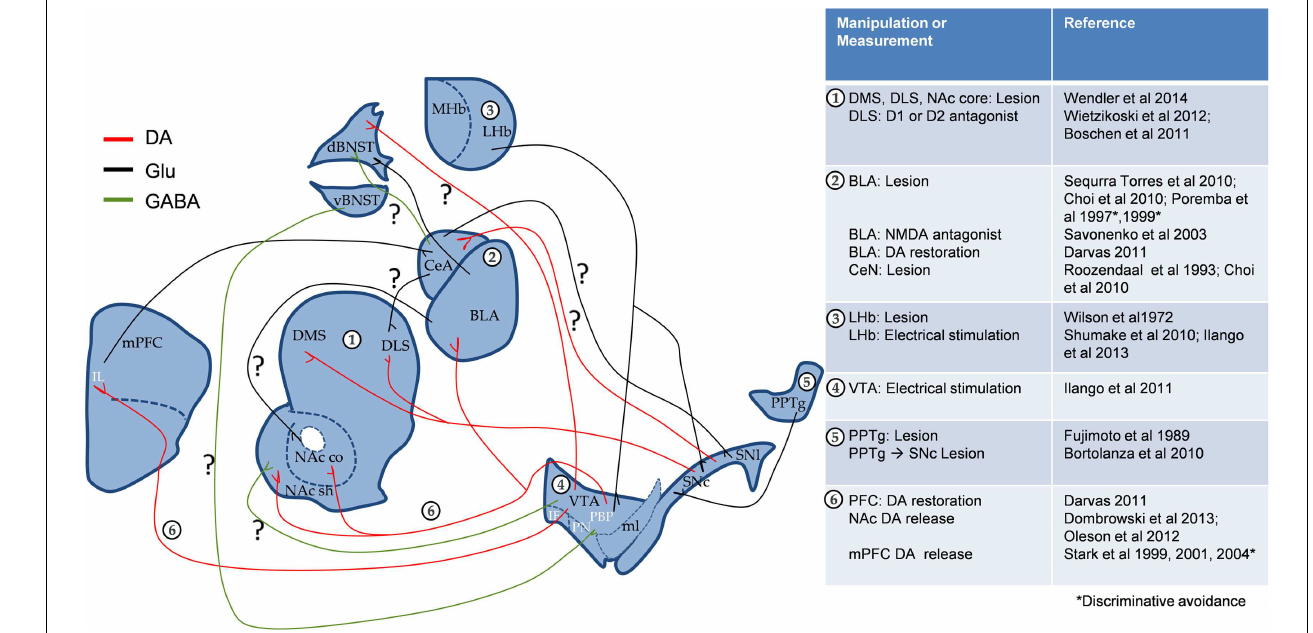
paranigral nucleus; IF, interfascicular nucleus); SN, substantia nigra (c, compact part and l, lateral part); ml, medial lemniscus; CeA, central nucleus of the amygdala; BLA, basolateral amygdala; BNST, bed nucleus of the stria terminalis; MHb and LHb, medial and lateral habenula; PPTg, pedunculopontine tegmental nucleus; DMS, dorsomedial striatum; DLS, dorsolateral striatum.To simplify the circuit, the direct and indirect pathways of striatum were